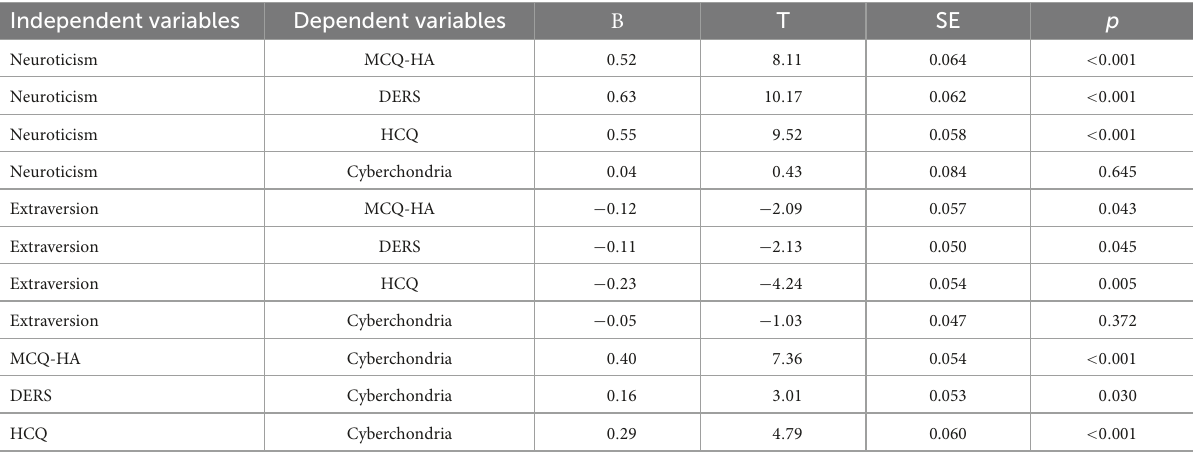
TABLE 3 Direct effects between latent